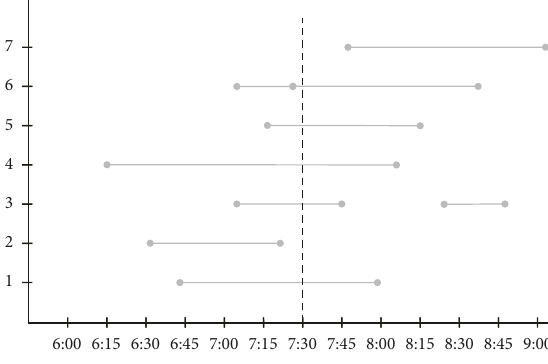
Figure 10: Trip Diagram from a Survey.